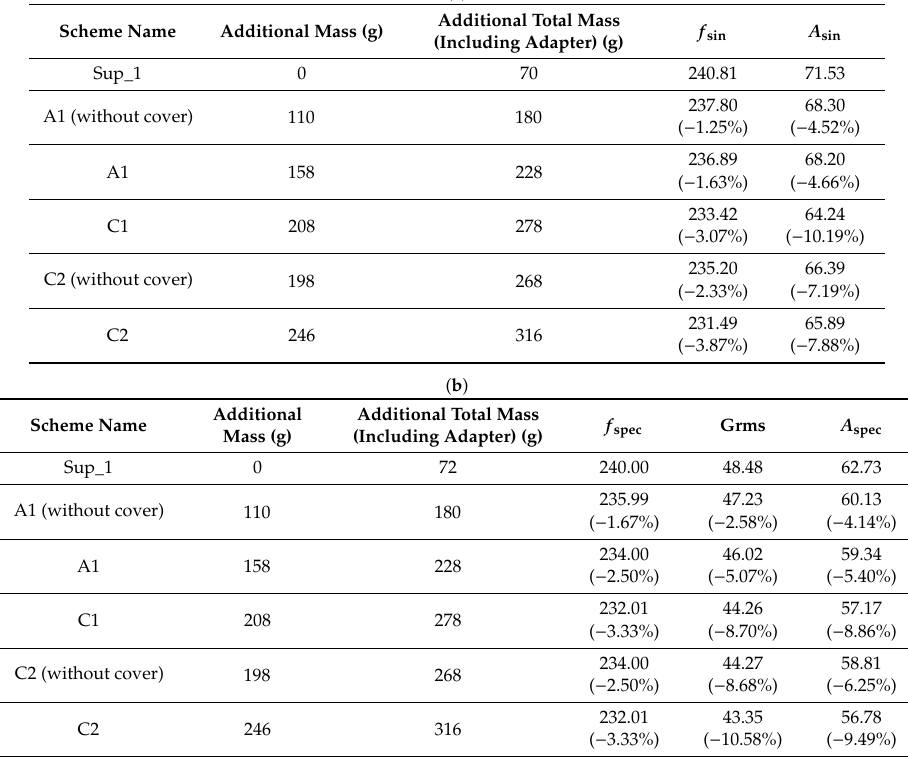
Table 5. The e ff ect of the cavity and the adapter: ( a ) Sinusoidal excitation; ( b ) Random